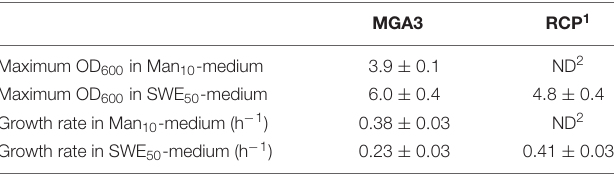
TABLE 3 | Growth of strains MGA3 and RCP in SWE 50 -medium and Man 10 -medium.